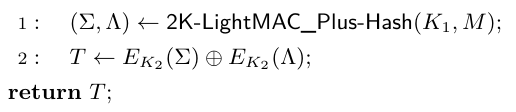
Figure 5.2: Algorithm for 2K-PMAC_Plus 2K-LightMAC_Plus